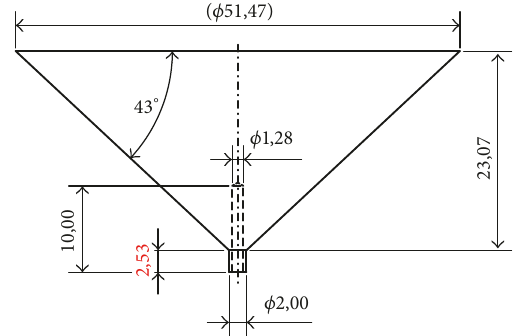
Figure 12: Cone dimensions of the broadband monopole antenna. The cylindrical stub on the bottom (red) is designed to fit over the inner conductor of an SMA flange, its length is adjusted to the thickness of the ground plane. All dimensions are in millimeter (reprinted with permission from [35]; ©2017 IEEE).